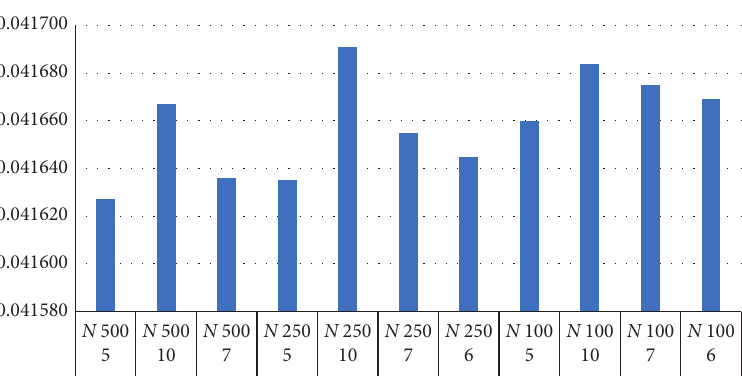
Figure 8: The comparison of the numbers of hidden layers.